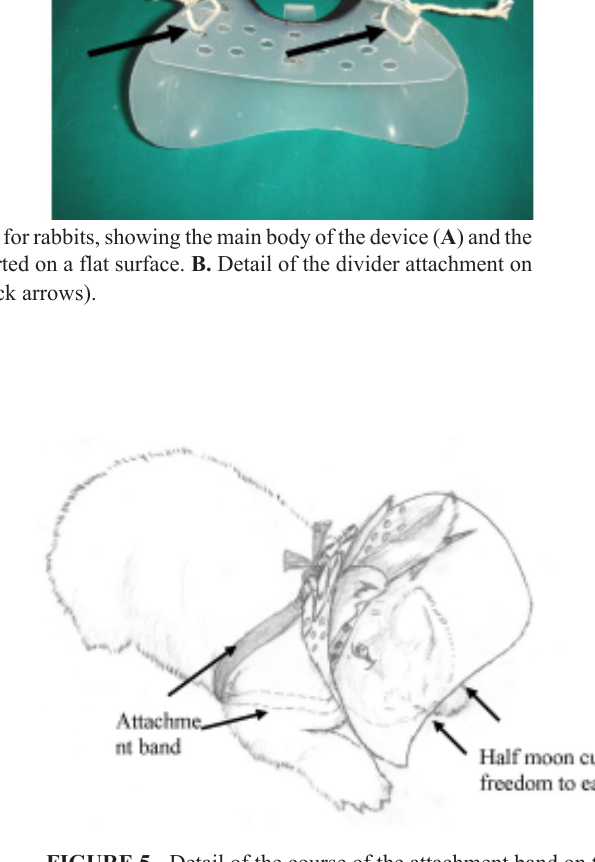
FIGURE 4 – Photograph of the compartment divider piece in position (white arrow). Detail of the holes in the divider and the upper compartment to permit better ventilation of the ears (black arrows)